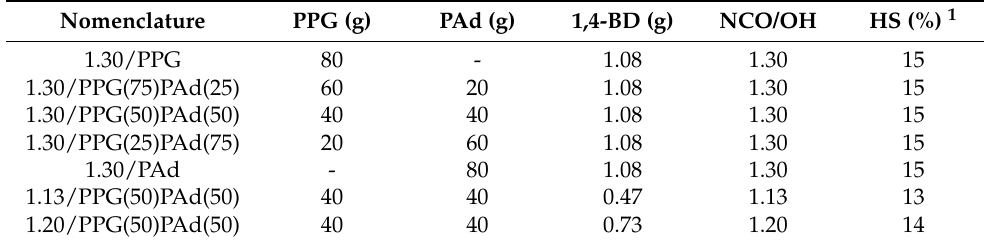
Table 1. Nomenclatures and compositions of the